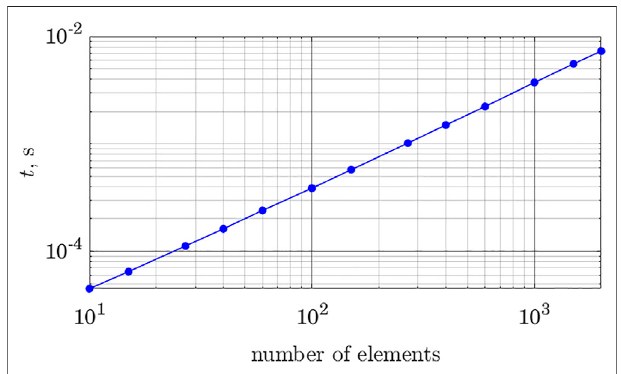
FIGURE 6 | Computational time as a function of dataset size; both axes are in logarithmic